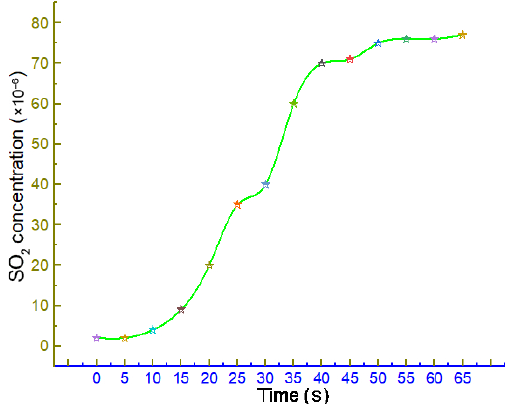
Fig. 7 Experimental result of SO 2 concentration in air.